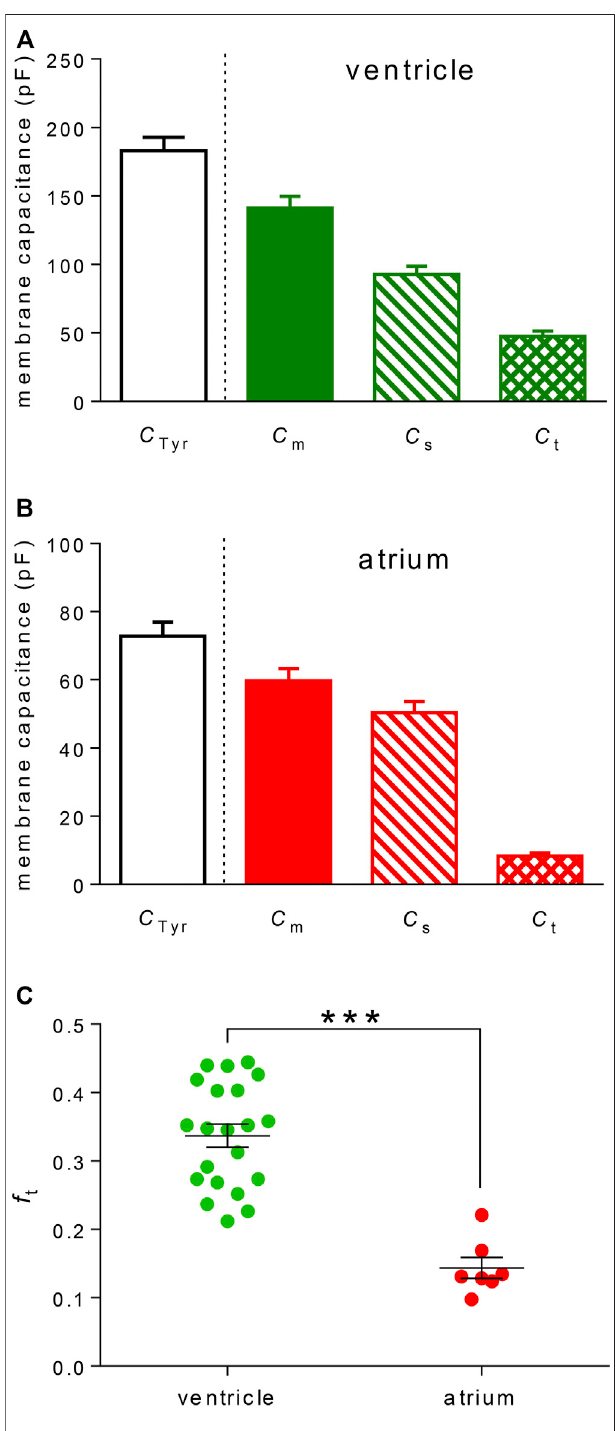
FIGURE 3 | TATS characteristics evaluated using the newly developed method. (A,B) Average C Tyr , C m , C s , and C t in ventricular (A) and atrial (B) cardiomyocytes. Values of all parameters in ventricular cells were signi fi cantly different at p < 0.001 ( n = 21). In atrial cells, all parameters also signi fi cantlydiffered,butatvarious P ( p < 0.05 – 0.001; n =7). (C) Thevalueof f t was signi fi cantly lower in atrial vs. ventricular cardiomyocytes; *** — statistical signi fi cance at p <